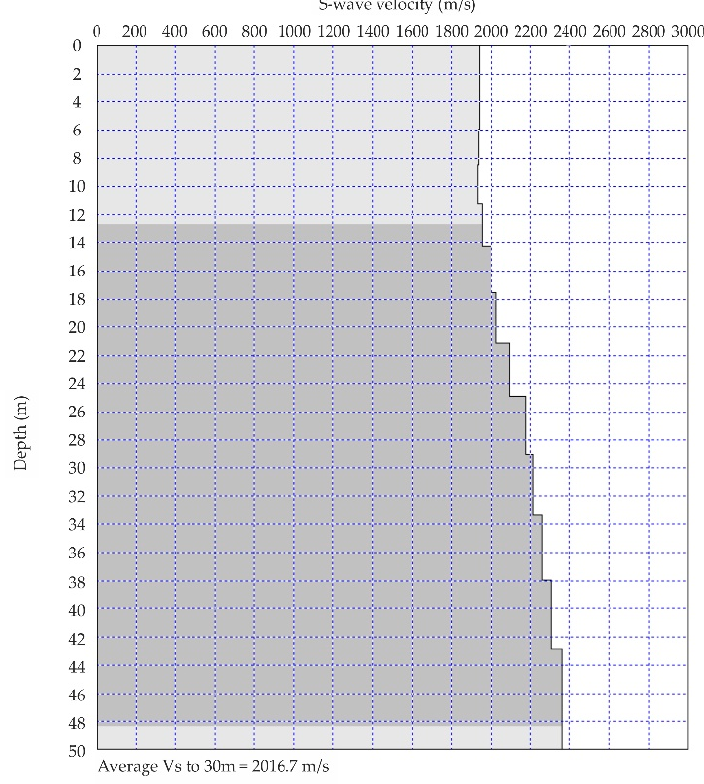
Figure A6. 1D Vs model derived from the MASW technique at ATAL station.